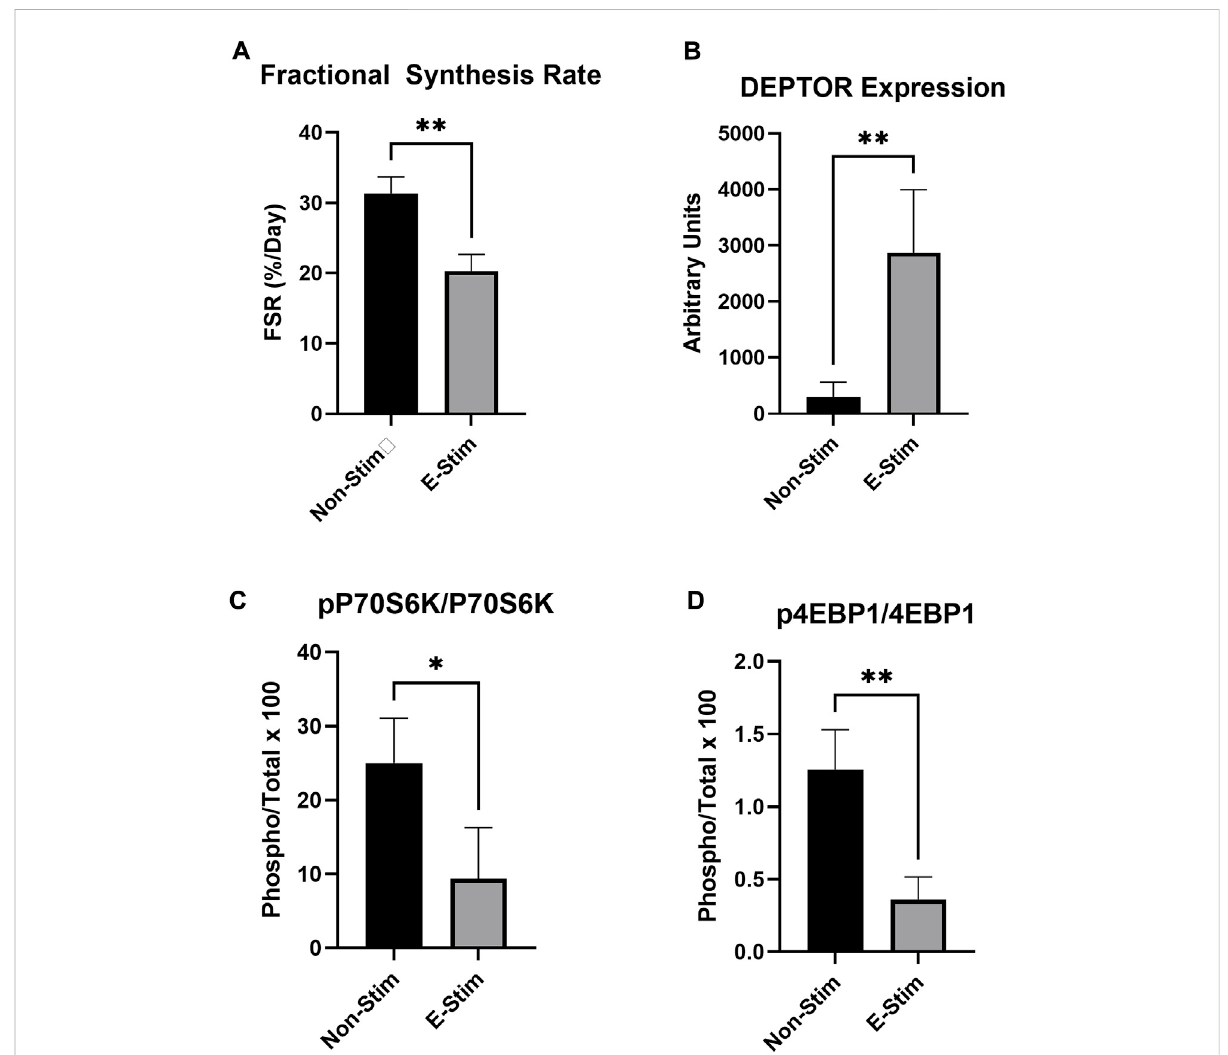
E-Stim perfusate suppresses anabolic signaling in MCF7 breast cancer cells. Cellular protein fractional synthesis rate was reduced by E-Stim perfusate treatment (A) . E-Stim perfusate also lead to an accumulation of the endogenous mTOR inhibitor DEPTOR (B) , concomitant with reduced signaling through the downstream targets of the anabolic mTOR kinase (C,D) . * denotes p < 0.05, ** denotes p <